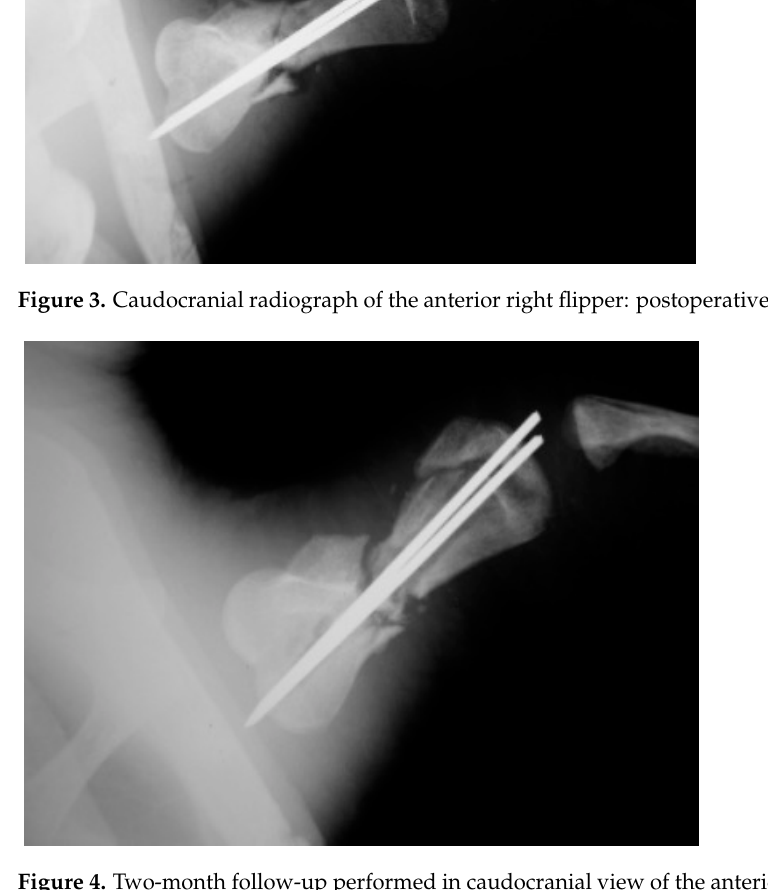
Figure 5. Postoperative checkup at four month: Caudocranial view of the anterior right flipper showed a complete repair of the epiphyseal fracture while the diaphyseal fracture still lacked unifying callus tissue.